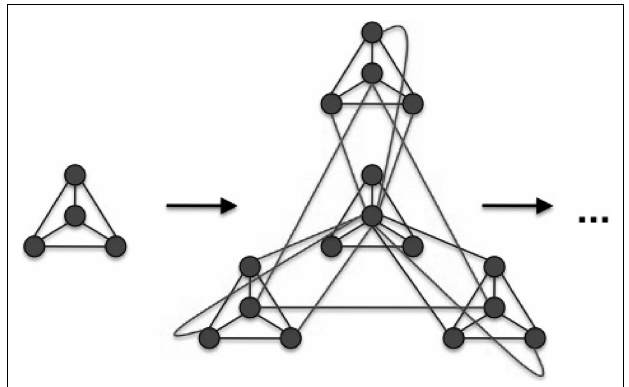
FIGURE 1 | Iteration step in the recursive construction of the hierarchical graphs from Ravasz et al. (2002) and Ravasz and Barabási